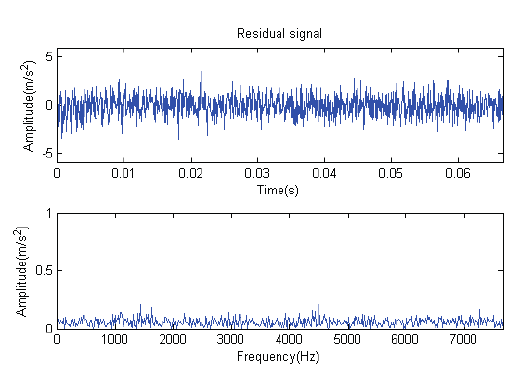
Figure 32. Residual signal.